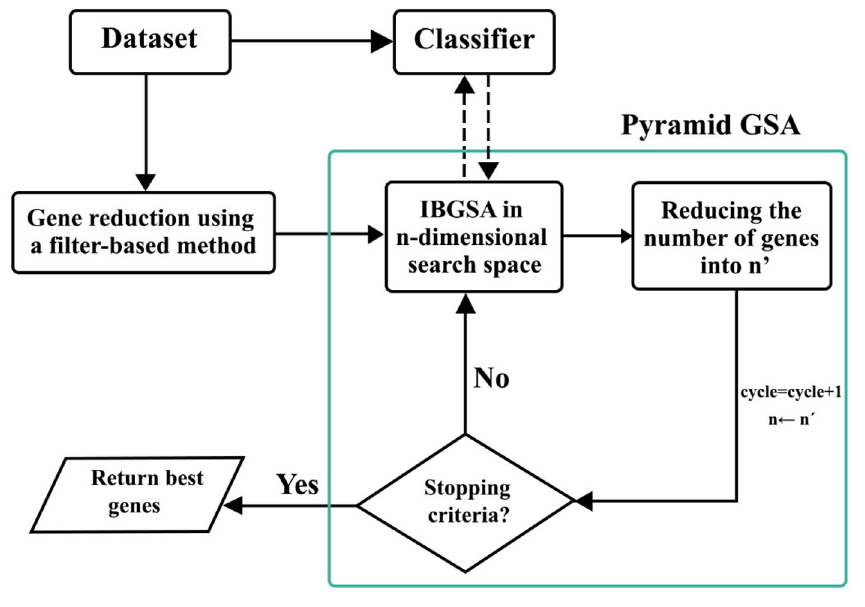
Fig 1. Gene selection using